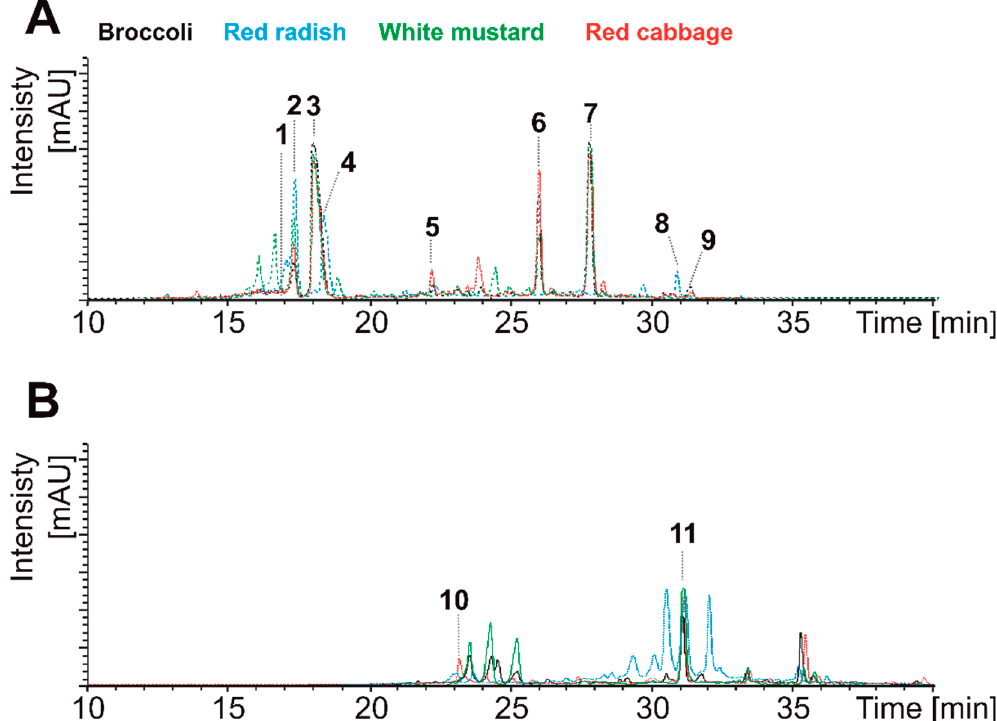
Figure 1. Peak identities in the analytical extracts of plant material ( A ) and the product resulting from the gastrointestinal digestion ( B ): (1) kaempferol sinapoyl-diglcusoside-7-glucoside; (2) sinapoyl-glucose; (3) kaempferol—7-gucoside-3-sinapoyl diglucoside; (4) unknown synapoyl derivative; (5) feruloyl-glucose; (6) disinapoyl-gentibiose; (7) trisinapoyl-gentibiose; (8) disinapoyl-glucose; (9) disinapoyl-glucose (isomer); (10) synapoyl-gentibiose; (11) sinapic acid.